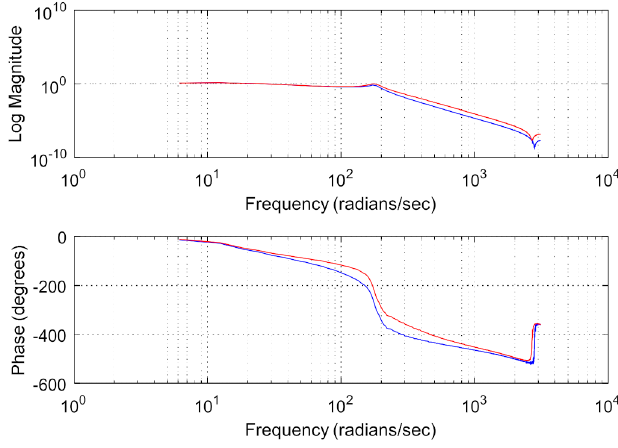
Figure 9. Bandwidth comparison of the two algorithms.